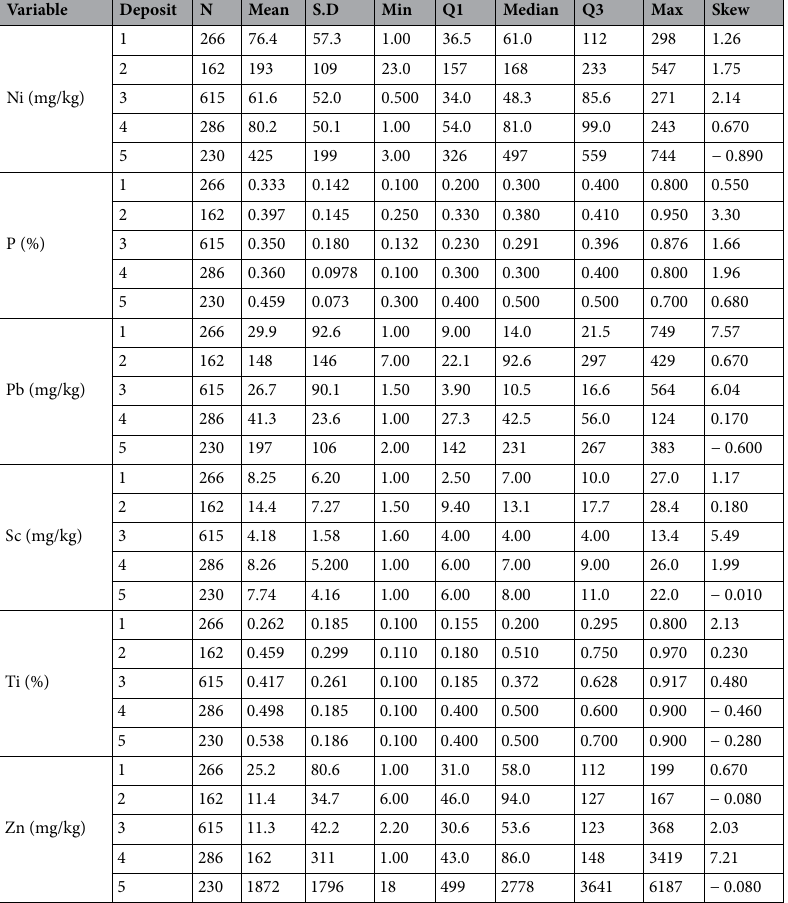
Table 3. Statistical summary of chemical variables of tails deposits 1 to 5. LOD bellow detection limit